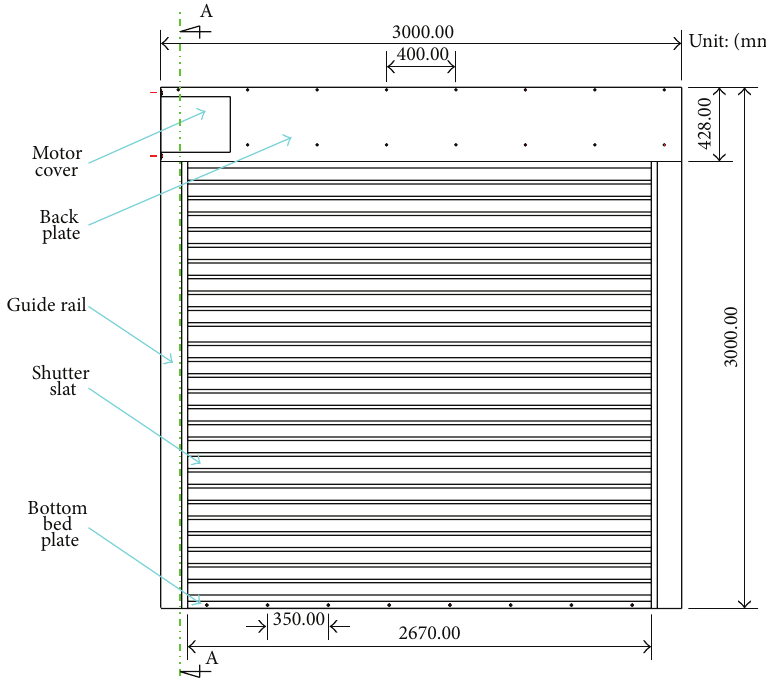
Figure 4: Front view of rolling door (face to roller box).